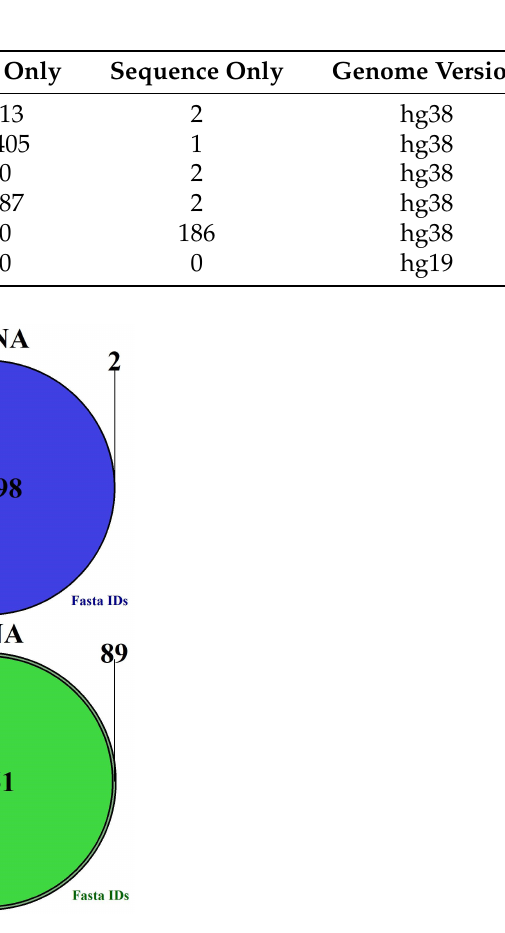
Figure 1. Visualization database completeness of both sequence data and loci data for various small RNA types. ( A ) For microRNA. ( B ) For piRNA. ( C ) For mature tRNA. ( D ) For